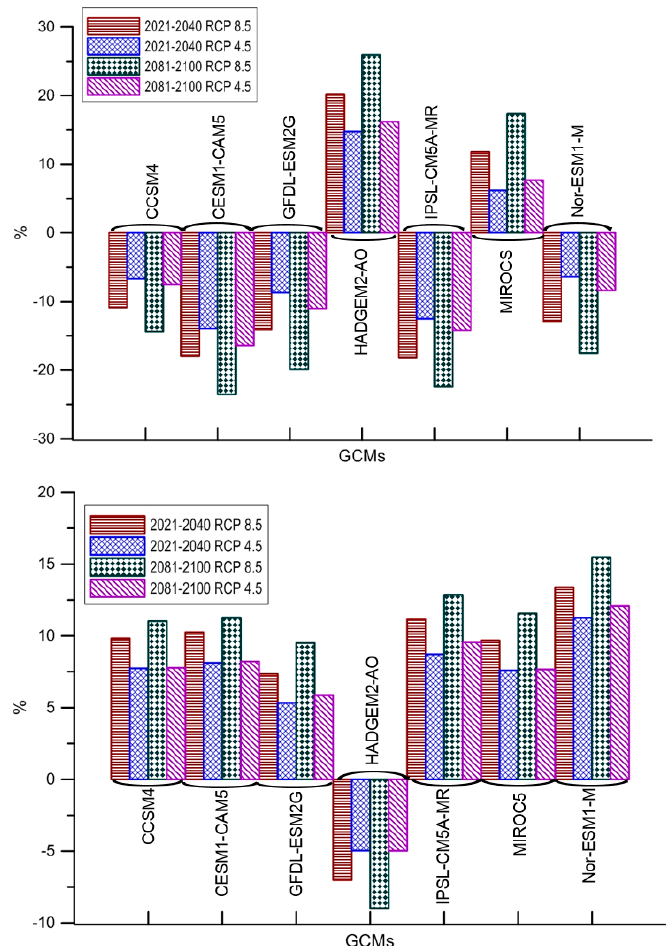
Figure 6. Projected change of runoff for a period 2021–2040 and 2081–2100 in dry ( top ) and wet season ( bottom ) of Gilgel Abbay watershed with reference to the baseline (1980–1999) under RCP 8.5 and RCP 4.5.